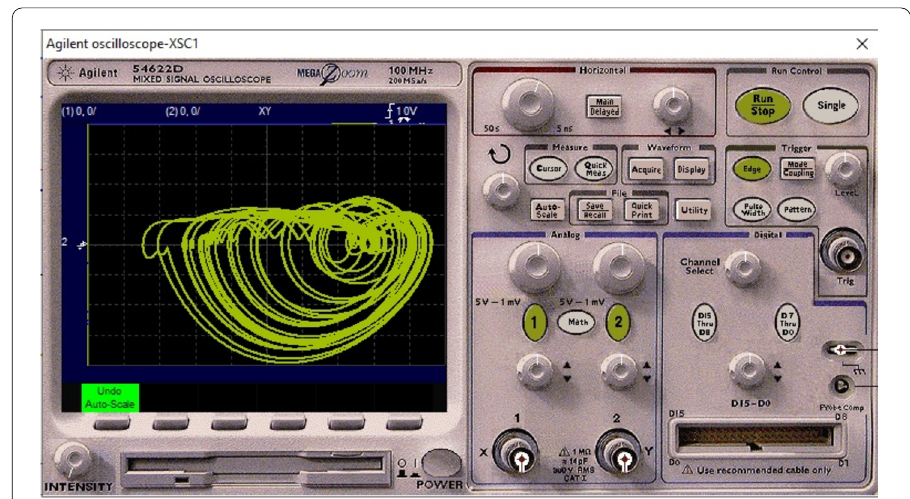
Figure 17 The plot of Z 2 versus Z 1 from the electronic circuit